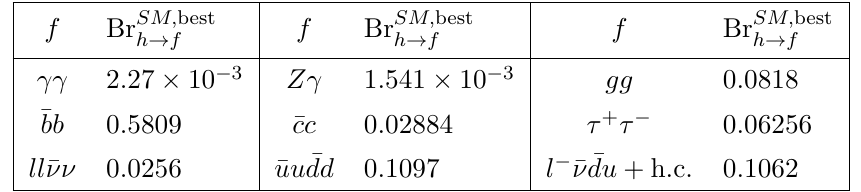
Table 6 . Numerical values of the Higgs boson branching ratios employed in the definition of δ Γ h , eq. (6.17). The values for 2-body decays are taken from ref. [107], with m = 125 . 09 GeV . The h values in the last line are estimated computing the partial widths with Prophecy4f 2.0 [108] and normalizing their sum to Br SM, best = 0 . 24161 [107]. They include only charged current contribu- h → 4 f tions and are summed over all allowed flavor